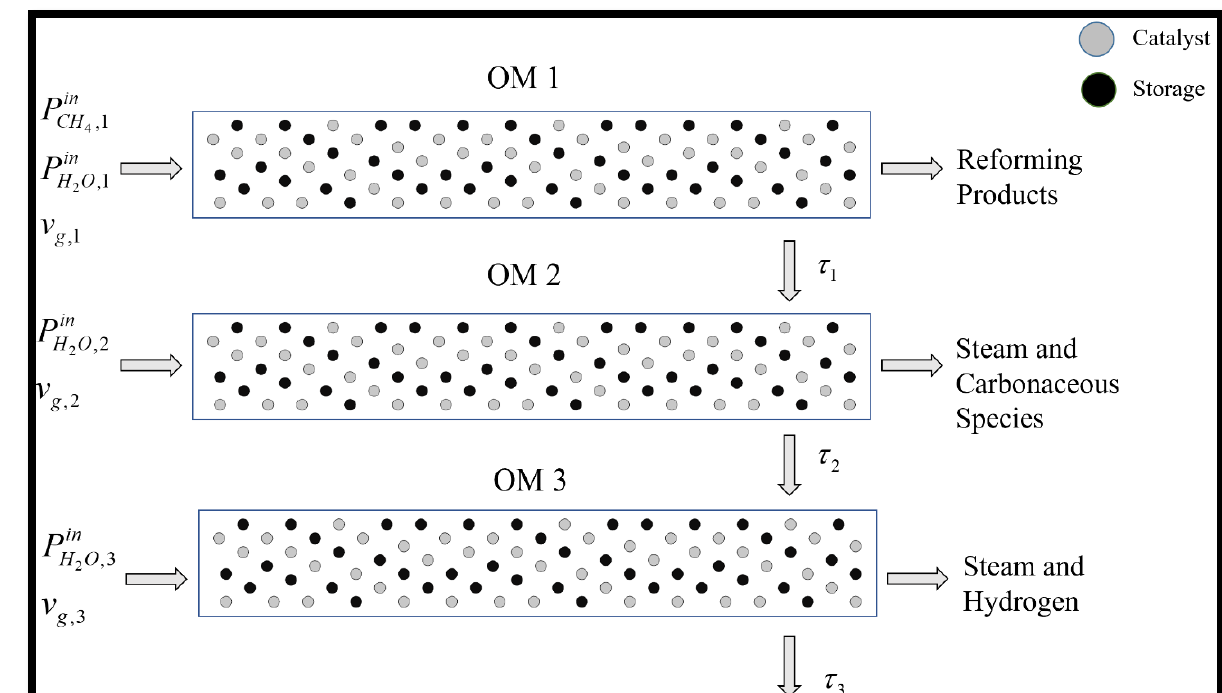
Figure 1 . Proposed SMR-MSR process and its operating modes . Figure 1. Proposed SMR-MSR process and its operating